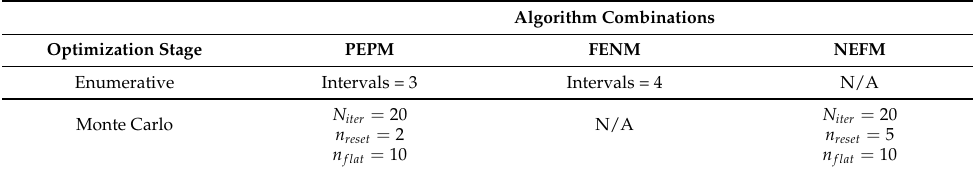
Table 4. Parameters for each of the three optimization